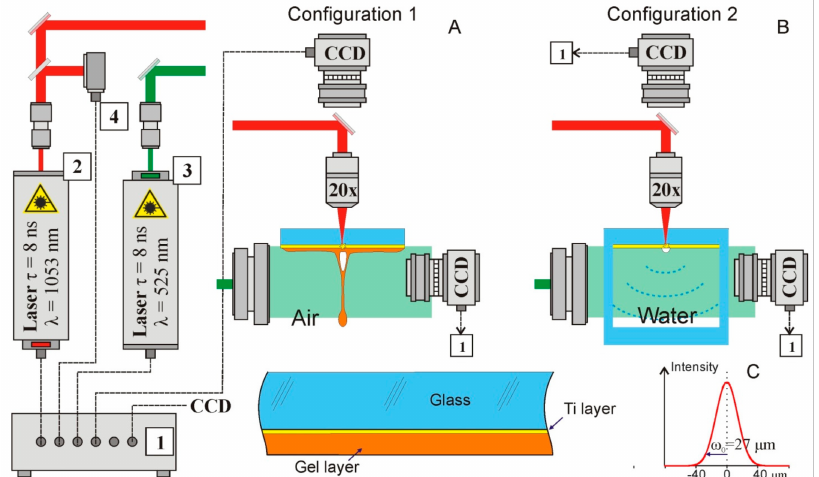
Figure 1. Schematic diagram of a setup for studying dynamic processes using time-resolving shadow microscopy using a donor glass plate with a thin Ti layer in two configurations: ( A )—in LEMS geometry with a gel layer applied to the donor plate (enlarged image below) and ( B )—in a glass mini-cell with water. ( C )—intensity distribution in the laser spot. 1—real-time controller; 2—IR nanosecond laser; 3—visible nanosecond laser;